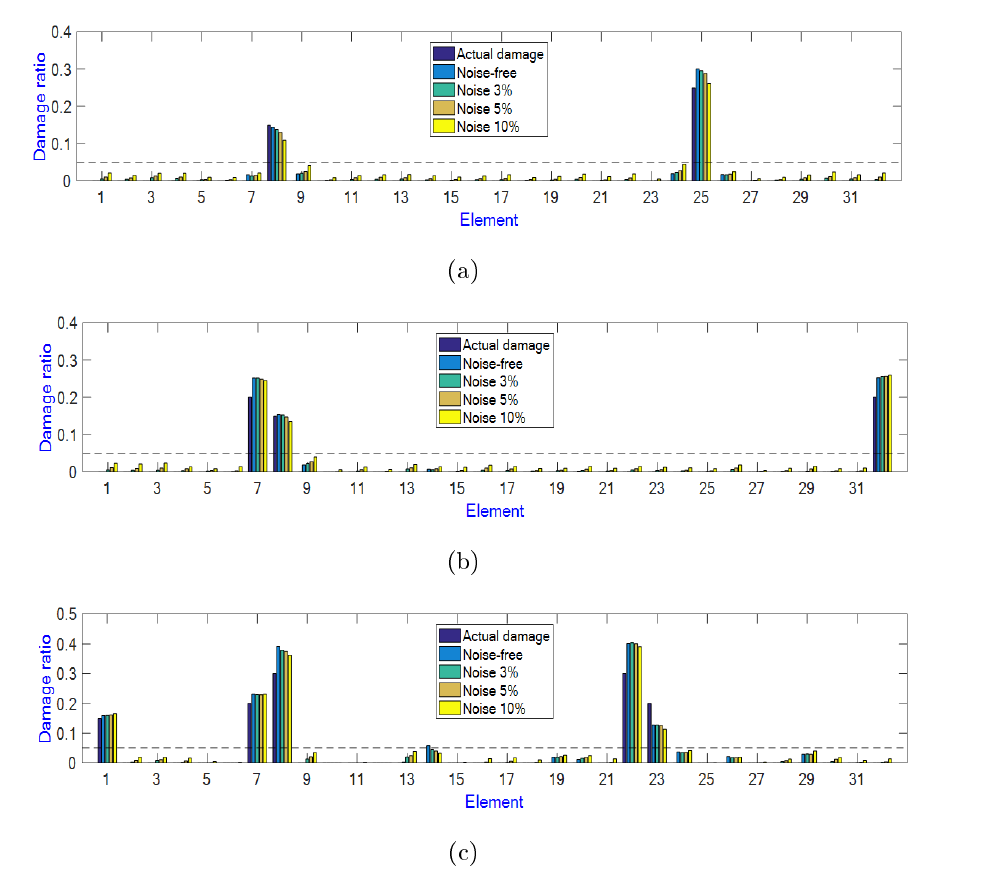
Fig. 3. Damage identi(cid:28)cation results obtained by damage indicator MKECR for three hypothetical damage scenarios of the two-span continuous cross-ply ( 0 o / 90 o / 0 o ) beam: